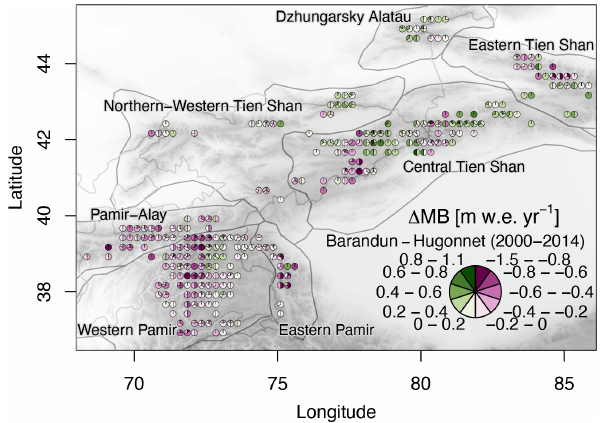
Figure 2. Difference in mean annual glacier mass balance between Barandun et al. (2021a) and Hugonnet et al. (2021) for the pe- riod 2000–2014 (see Fig. A1 for the period 2000–2018). Estimates from Hugonnet et al. (2021) only include the glaciers for which the transient-snowline-constrained modeling of Barandun et al. (2021a) provides estimates. The pie charts aggregate values per glacier into classes and the relative class frequencies. Pie charts are not scaled to glacier